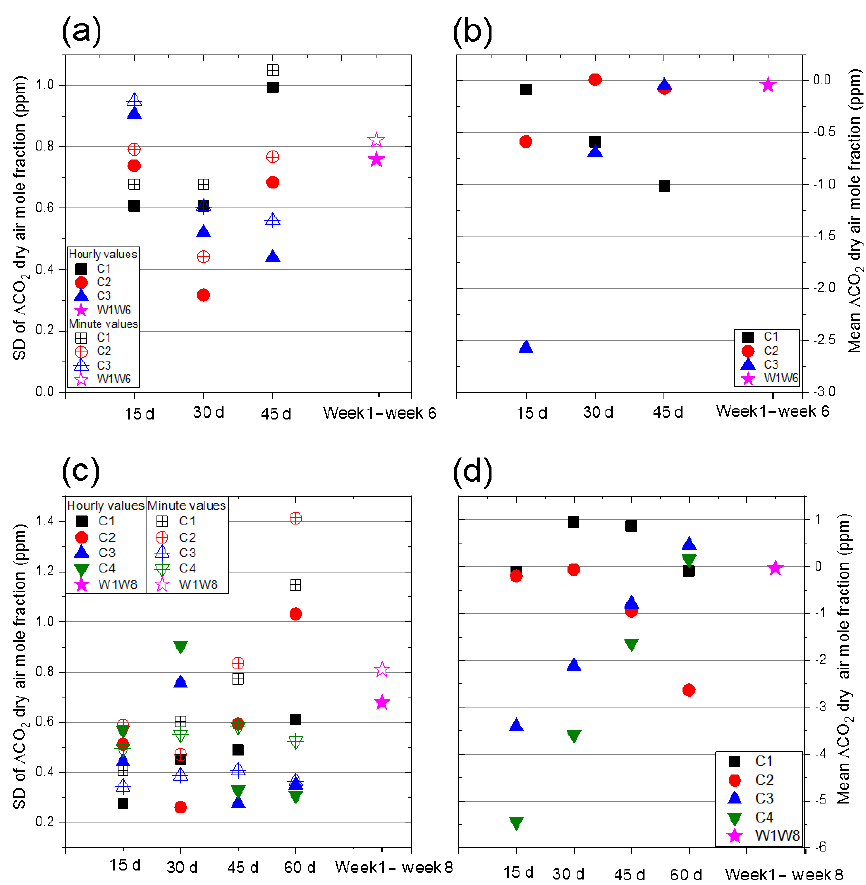
Figure 7. SD (cid:49) {CO 2 } (a) and mean (cid:49) {CO 2 } (b) values considering three calibration periods of 15 consecutive days for calibration each, with C1, C2 and C3 corresponding to the first, second and third 15 consecutive days of measurements at the Saclay field site respectively. W1W6 corresponds to using the first and sixth weeks as the calibration period. Mean (cid:49) CO 2 calculated for the four calibration periods. SD (cid:49) {CO 2 } (c) and mean (cid:49) {CO 2 } (d) values considering four calibration periods of 15 consecutive days for calibration each, with C1, C2, C3 and C4 corresponding to the first, second, third and fourth 15 consecutive days of measurements at the Jussieu field site respectively. W1W6 corresponds to using the first and eighth weeks as the calibration period. Hourly and minute values are represented as full and empty symbols respectively. Table 3. SD and mean values of 1min average (cid:49) {CO 2 } data for each correction step. Note that corrections are cumulative from left to right. Reported Offset Pressure Temperature RH Drift (raw) correction correction correction correction correction SD (cid:49) {CO 2 } (ppm) 1.11 1.03 1.00 0.97 0.97 0.67 Mean (cid:49) {CO 2 } (ppm) 45.33 1 × 10 − 3 9 × 10 − 4 0.16 0.13 − 0 .